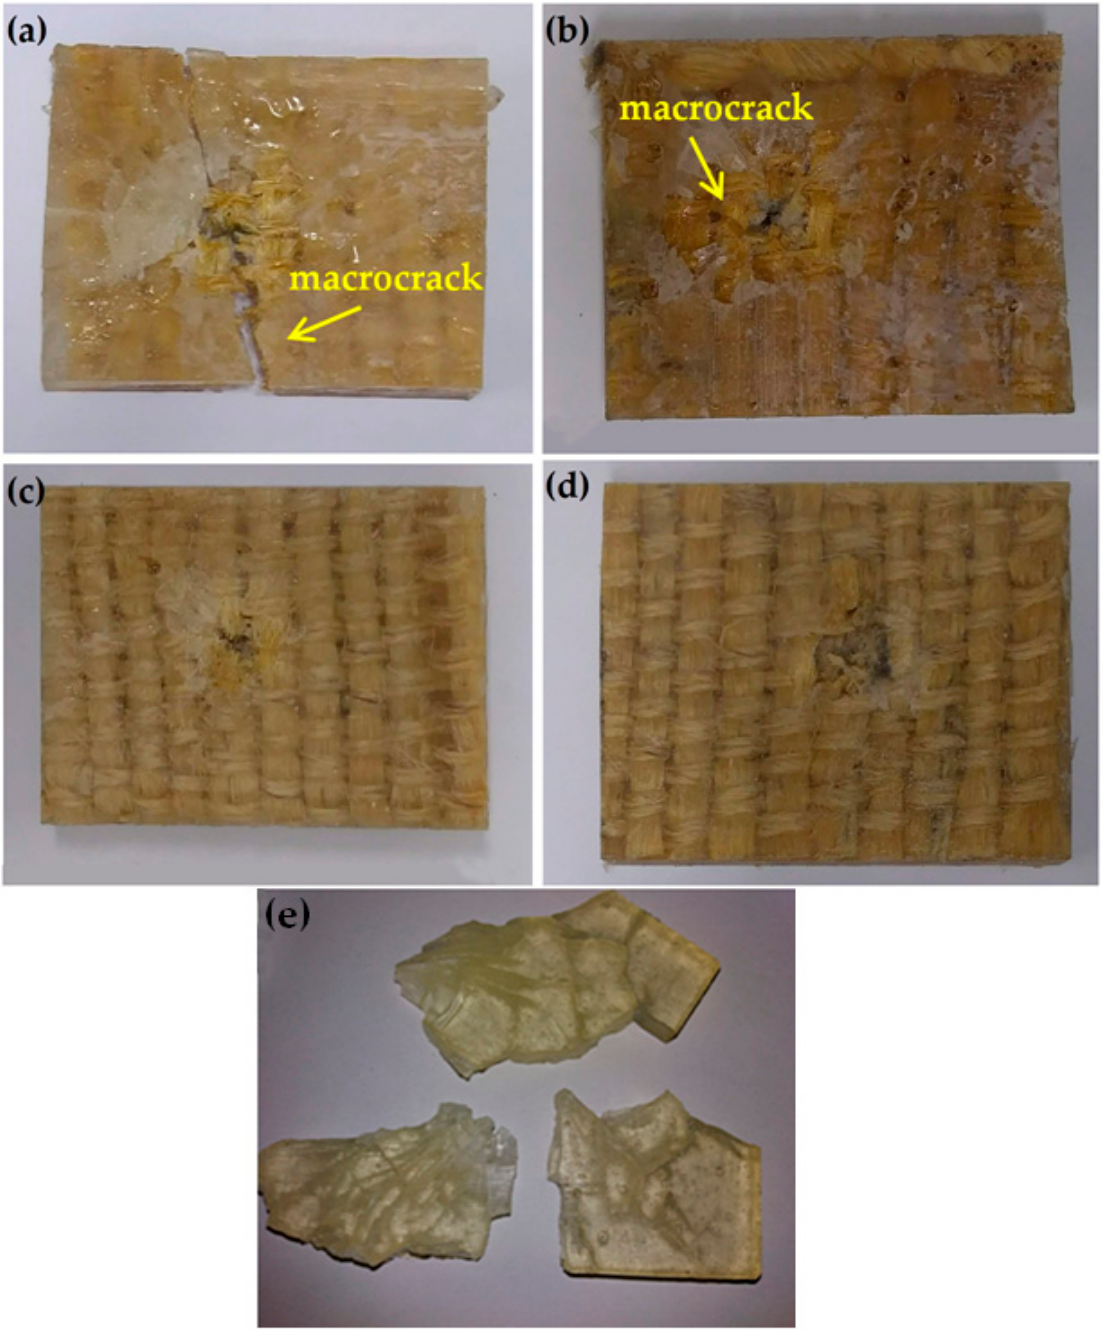
Figure 8. Stand-alone epoxy composite plates after the ballistic test against 7.62 mm ammunition: ( a ) 15 vol%; ( b ) 30 vol%; ( c ) 40 vol%; ( d ) 50 vol% fique fabric; and ( e ) plain epoxy plate.